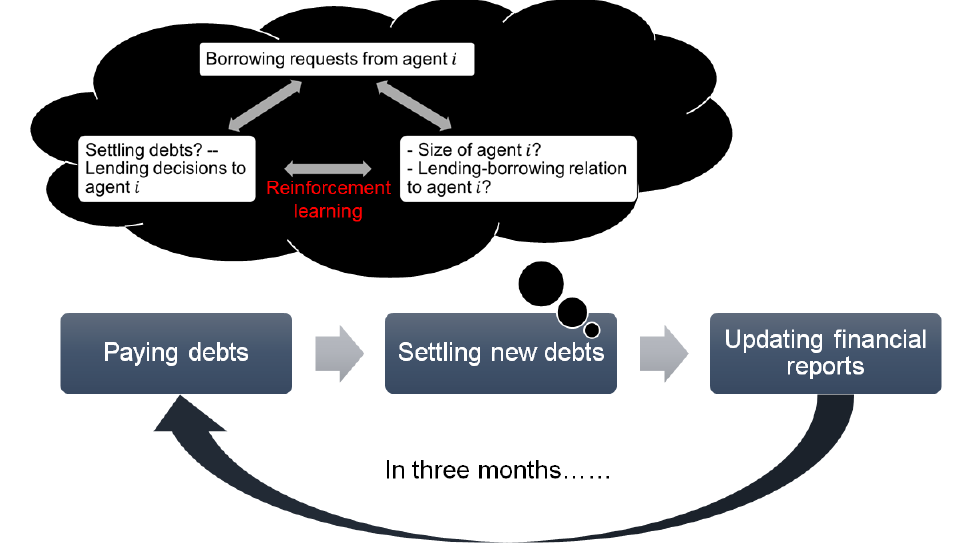
Figure 1. Agent’s behavior in the multi-agent interbank framework.